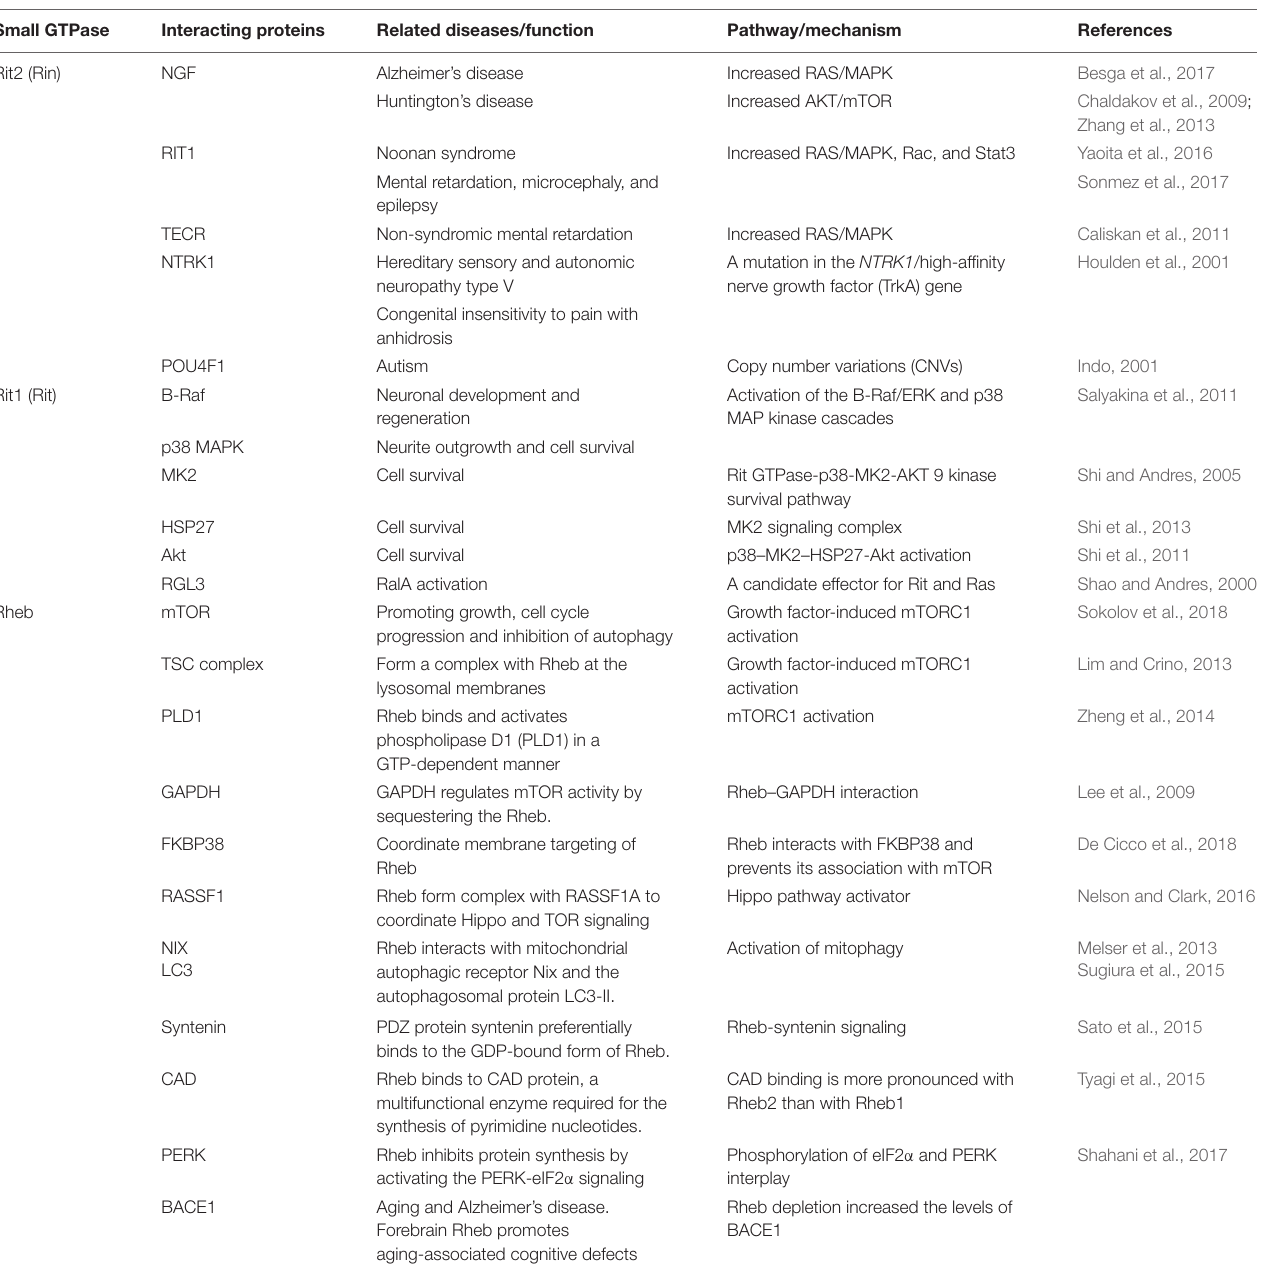
TABLE 2 | Interacting proteins related to Small GTPases (Ras